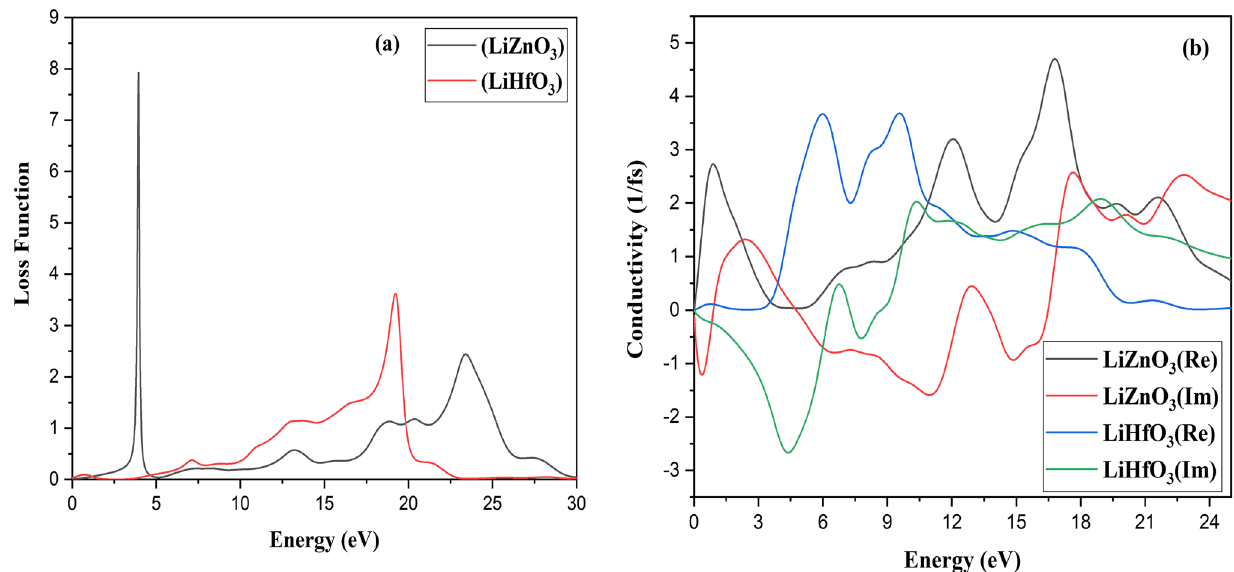
Fig. 9 Optical properties of LiZnO